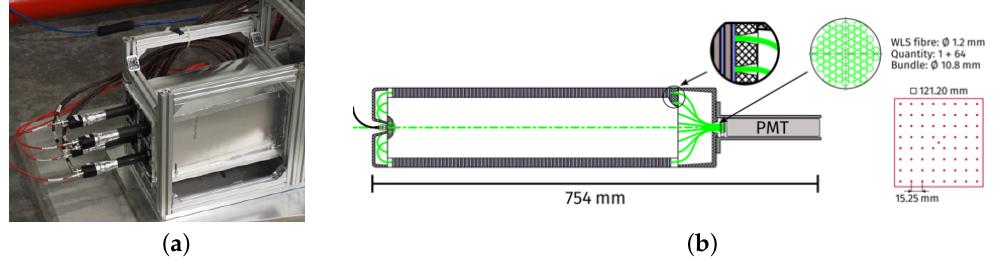
Figure 5. ( a ) A photograph taken of the FASER ECAL in the TI12 tunnel, showing the 2 × 2 layout. ( b ) A diagram of the LHCb outer ECAL modules [6] used in